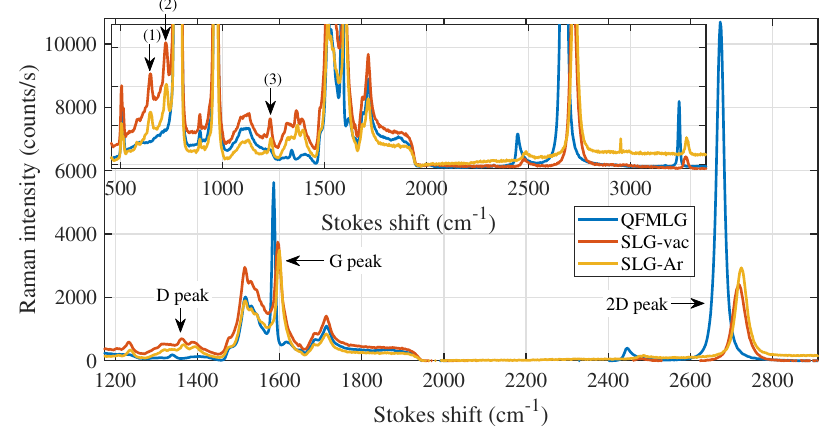
Figure 1. Raman spectra of quasi free-standing monolayer graphene (QFMLG), single layer graphene grown in vacuum (SLG-vac) and single layer graphene grown in argon (SLG-Ar). Graphene related D, G and 2D peaks are labeled by arrows. Inset shows details of Raman spectra including three buffer related Raman modes, labeled by arrows (1), (2) and